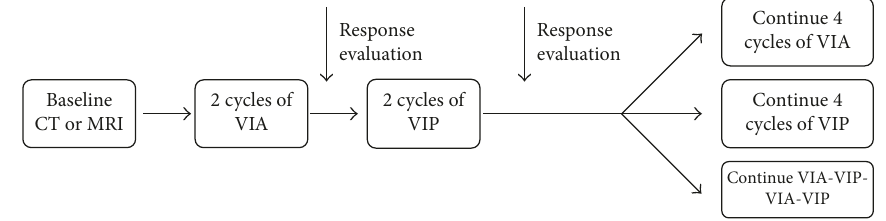
Figure 1: Outline of the chemotherapeutic regimen.